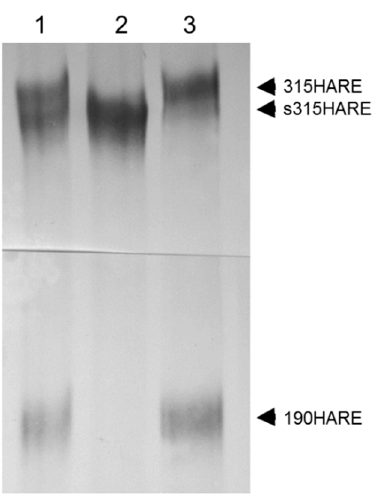
Figure 3. Membrane attachment is required for production of 190HARE. Cells expressing either 315HARE (Stabilin-2) or secreted 315HARE (lacking the transmembrane and cytoplasmic domains) were lysed in conditioned medium and immunoprecipitated with Ab30 conjugated to sepharose beads. Immunoprecipitated proteins from ( 1 ) cell lysate from both 315HARE and s315HARE were mixed 1:1, ( 2 ) s315HARE lyste, and ( 3 ) 315HARE lysate were separated by 5% SDS-PAGE on a 20 cm gel, blotted, and probed with anti-V5 antibody for protein detection.